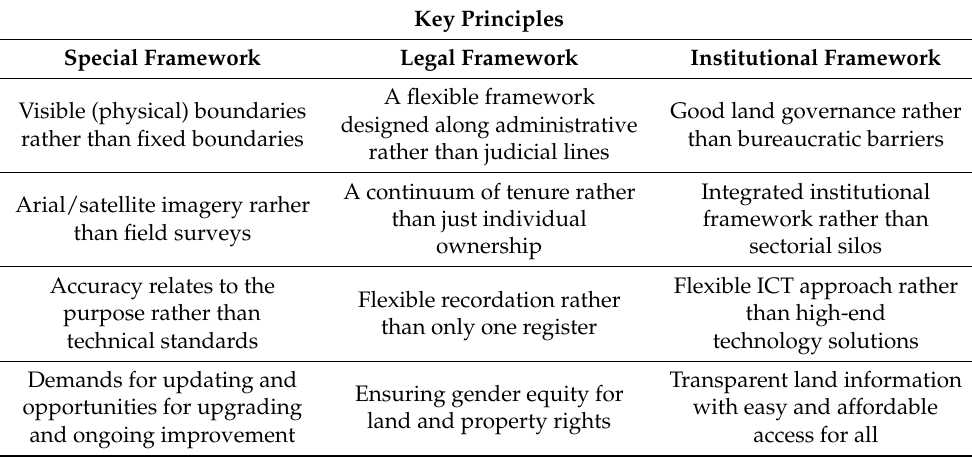
Table 1. The key principles of the fit-for-purpose approach (taken from [2]). Key